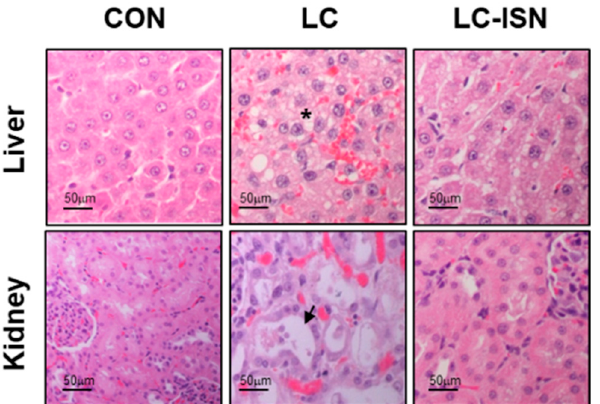
Figure 2. Liver and kidney biopsies in CON, LC and LC-ISN rats. Star symbol indicates tissue damages including necrosis and fibrosis in the liver. Arrow symbol indicates cell death and tissue damage in the kidney. CON, control; LC, liver cirrhosis induced by N -dimethylnitrosamine; LC-ISN, LC with treatment of isosakuranetin.